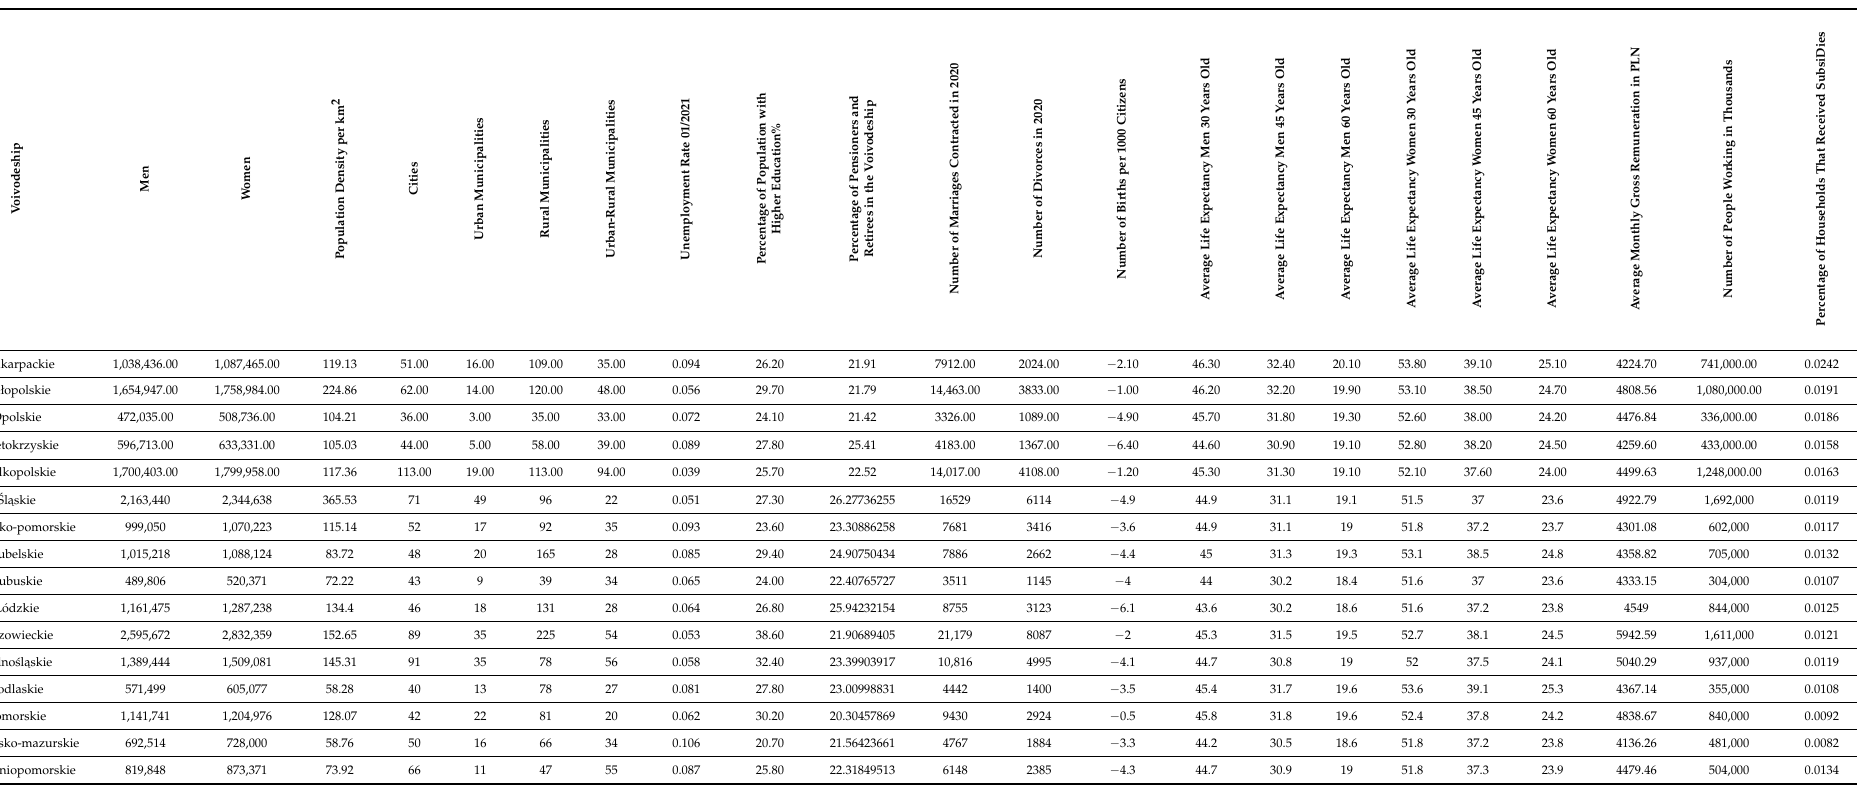
Table A3. The input data for consumer